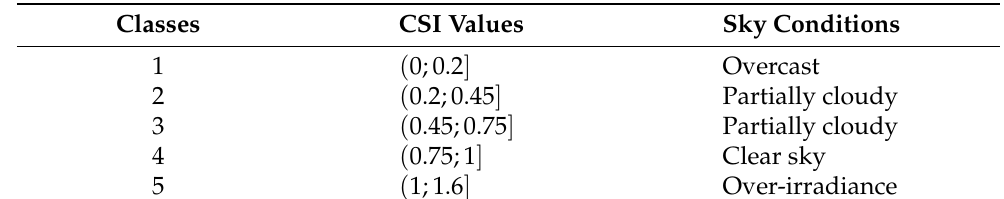
Table 2. Range of CSI values for each class.